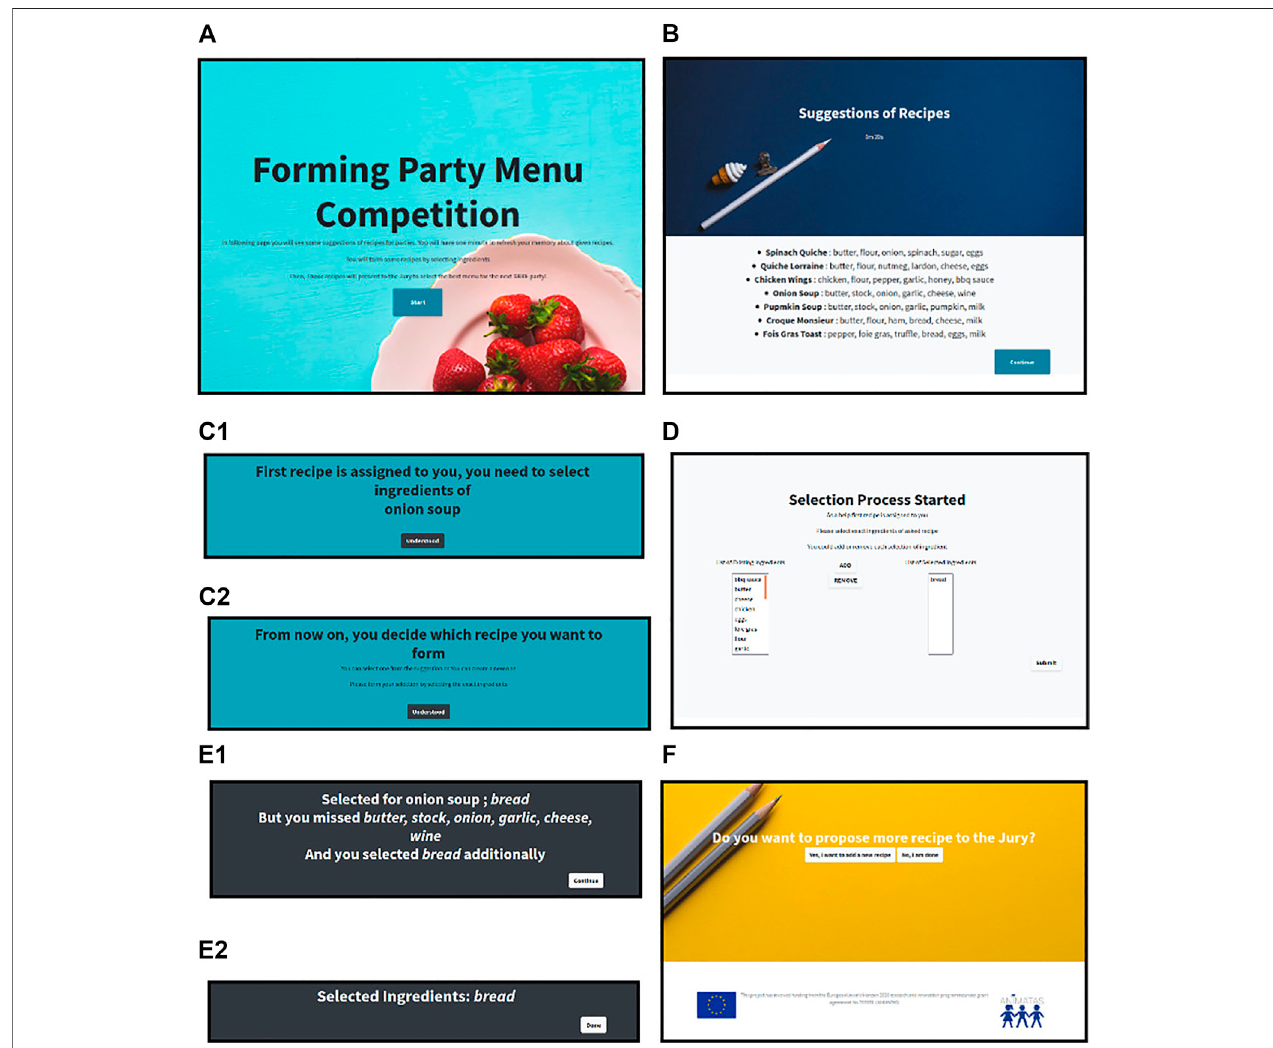
FIGURE3| GUIofcookingrecipetask;diagramcombinesthepagesoftheweb-based taskapplication.Aftertherobotconnected — additionalpagesomitted, (A) iswelcomingtheuserandexplainingabouttheaimofthetask. (B) isonlyvisiblefor1 min,anditpresentstheexamplesofrecipes. (C) ischangedaccordingtophasesof the task, (C1) is phase 1, where a dish is assigned, and (C2) is phase 2, where the participant has freedom of choice. (D) is the page where phases of the task occur, wheretherobotproactivebehaviorisactivated.Itisidenticalforallphases. (E) istheresultpagesaftereachselectionprocess.(E1)hasaspecializedviewforphase 1 which provides more information. (E2) is the result page for phase 2 which only shows the recent information ofselection. (F) isthe page that comes after phase 2 and lets the participants continue to create more dishes or fi nalize the task.